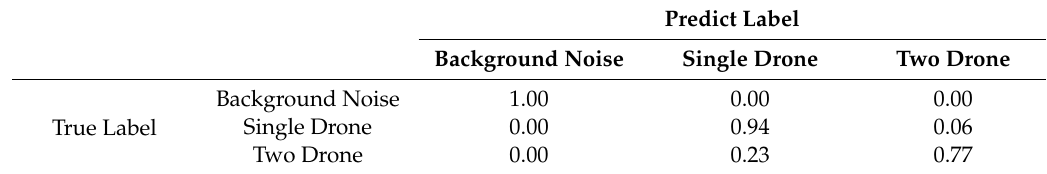
Table 3. The confusion matrix from CoNN with Wigner-Ville spectrogram classes.